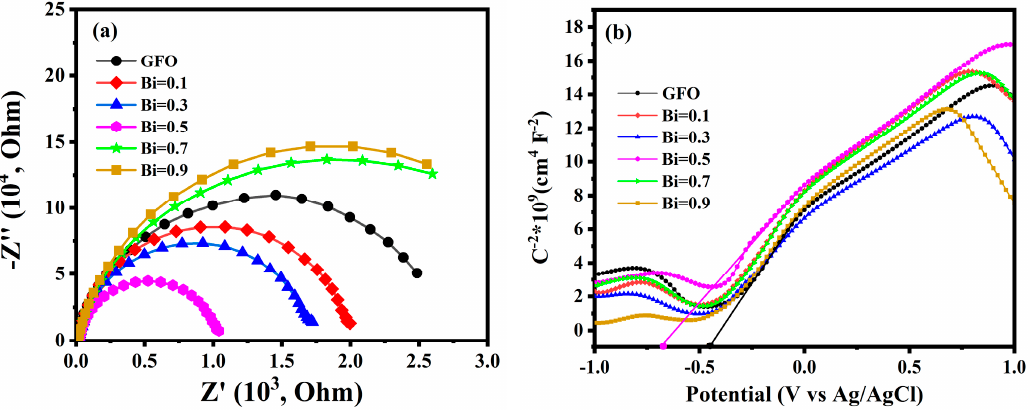
Figure 7. ( a ) Complex impedance spectra (Z’ vs. Z’’) and ( b ) Mott-Schottky plots of Gd 1 − x Bi x FeO 3 samples at room temperature.